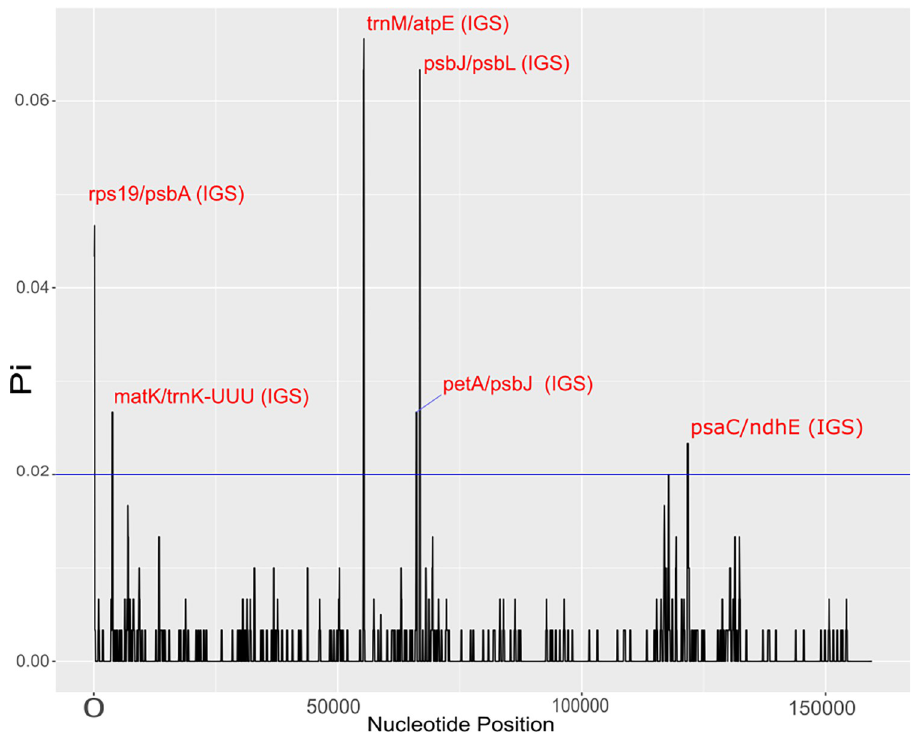
Fig 6. Sliding window analysis of the alignment from the chloroplast genome of Euterpe edulis , E . oleracea and E . precatoria chloroplast genomes. The regions with high nucleotide variability (Pi > 0.02) are indicated. Pi is the nucleotide diversity of each window, and the window length was 200 bp with 50 bp step sizes.